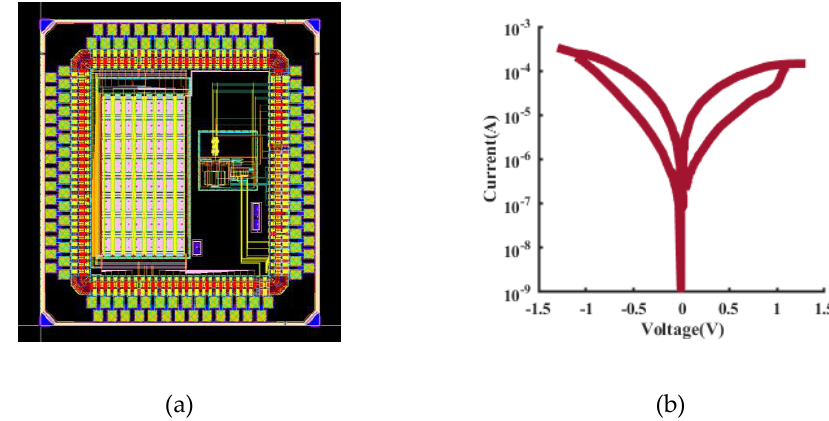
Figure 8. ( a ) Front-end circuit layout and ( b ) typical DC I–V curve for a single RRAM device.